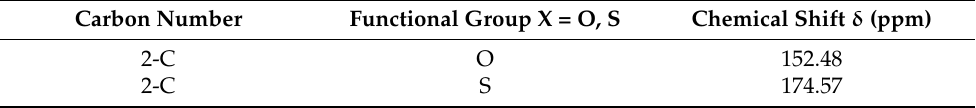
Table 2. 13 C-NMR (DMSO, 25 MHz) δ values.